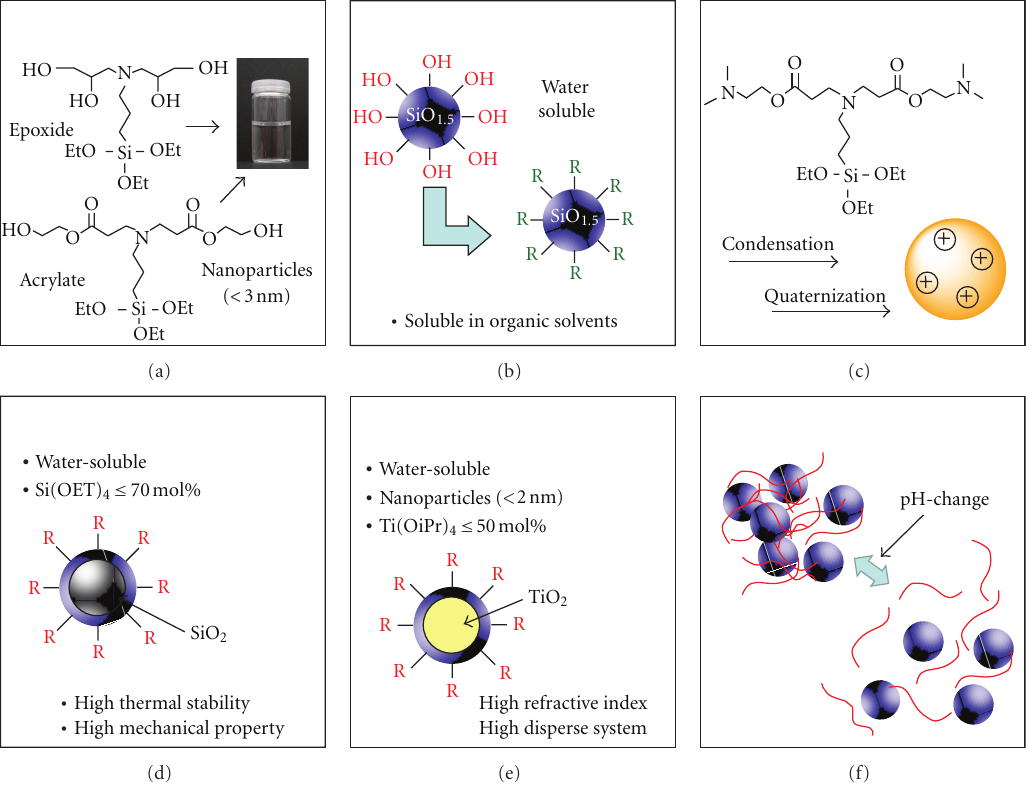
Figure 2: Summary of water-soluble silsesquioxane-based nanoparticles. (a) Water-soluble hybrids synthesized by hydrolytic condensation of hydroxyl-functionalized triethoxysilanes; (b) end-group modifications of the hydroxyl groups of the water-soluble hybrids; (c) cationic hybrids obtained by hydrolytic condensation, followed by quaternization; (d) R–SiO 1 . 5 /SiO 2 hybrids; (e) R–SiO 1 . 5 /TiO 2 hybrids prepared by hydrolytic cocondensation of the hydroxyl-functionalized triethoxysilane and metal alkoxides; (f) smart hybrids based on the complexation of the silsesquioxane nanoparticles and weak